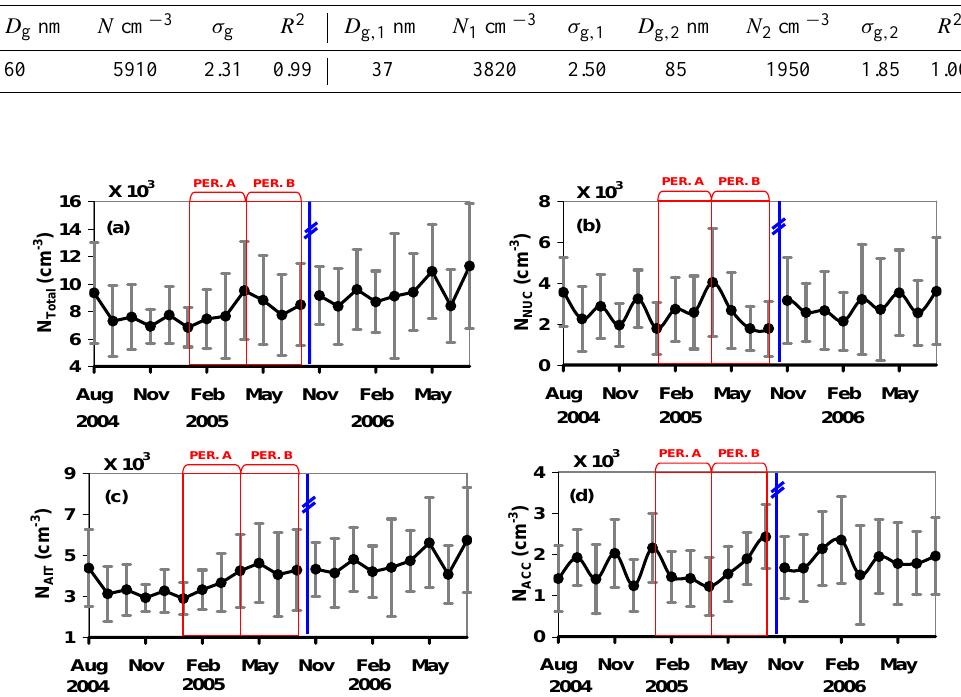
Fig. 3. Annual cycle with monthly mean levels for (a) N T , (b) N NUC , (c) N AIT and (d) N ACC . The standard deviation (grey vertical lines) is also shown, as well as two periods are selected (red lines) to better understanding of the monthly trend: Period A (January–April) 2005 and Period B (April–July) 2005. Blue lines indicate the break of the annual cycle due to the longest data